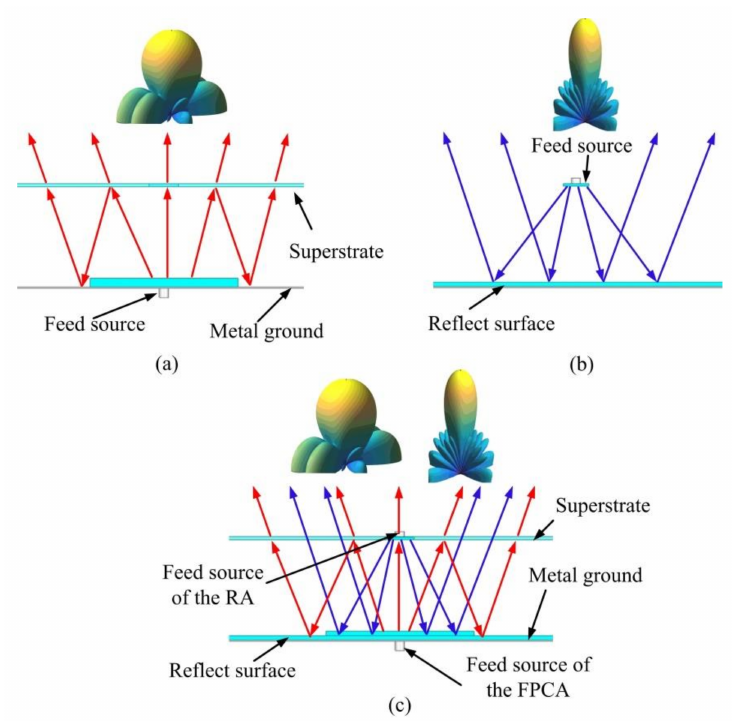
Figure 1. Working principle of a ( a ) Fabry-Perot cavity antenna (FPCA), ( b )reflectarray antenna (RA), and ( c ) shared-aperture